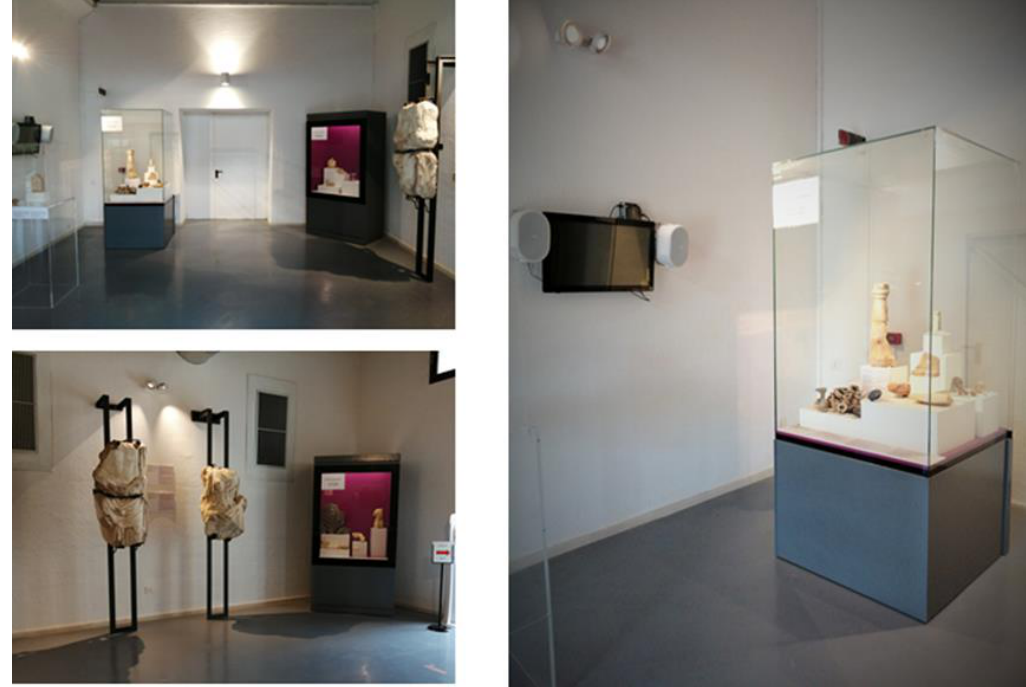
Figure 16. The room inside the Museum of the Archaeological Park of “Lilibeo” with finds from the sacred area of insula III exhibition.